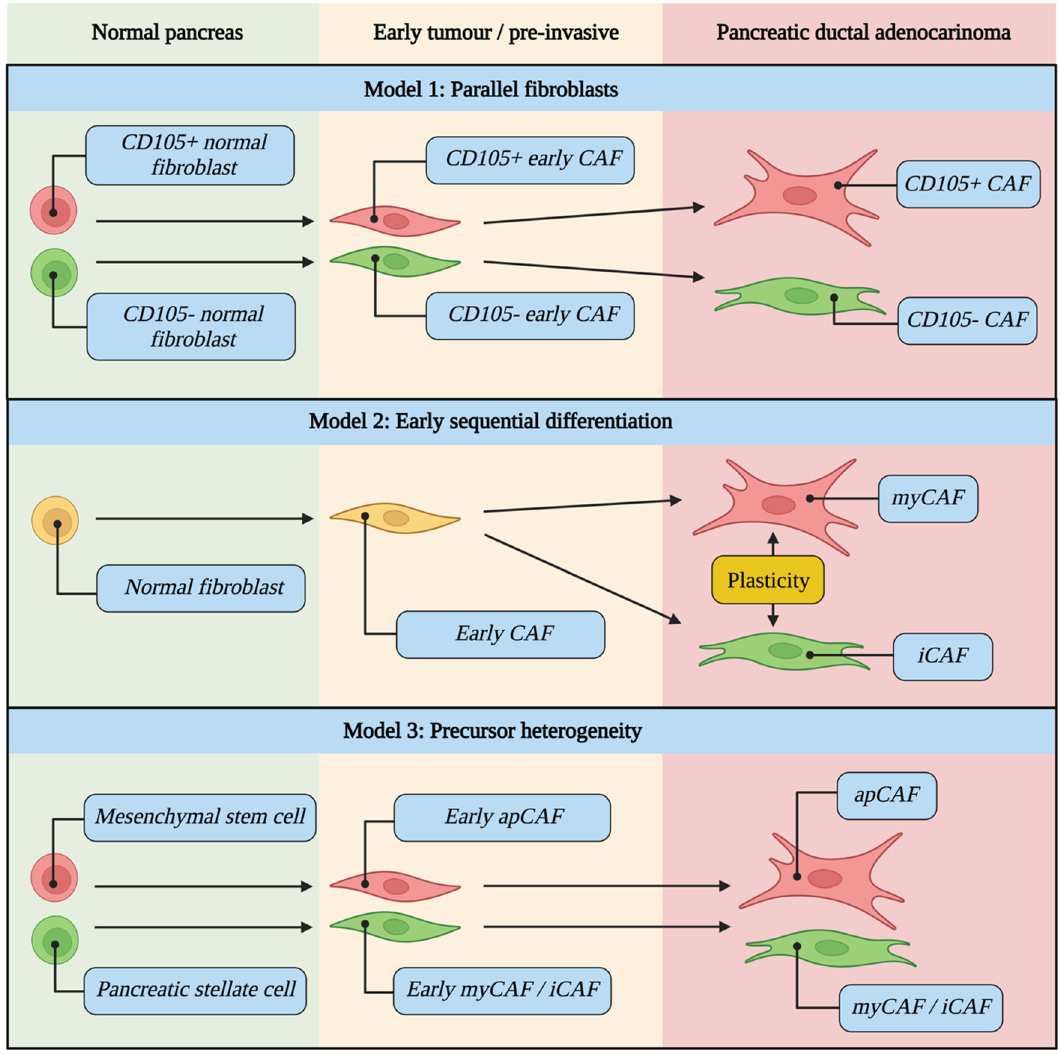
Figure 3. CAF evolutionary models during tumour development from normal pancreas to pre- invasive to PDAC. It remains unclear whether CAFs arise from heterogeneity within normal pancre- atic fibroblasts (Model 1), from a single normal pancreatic fibroblast population which subsequently differentiates during tumour development (Model 2), or from entirely different precursor cell types (Model 3). Examples of cell types for each scenario are highlighted in blue.